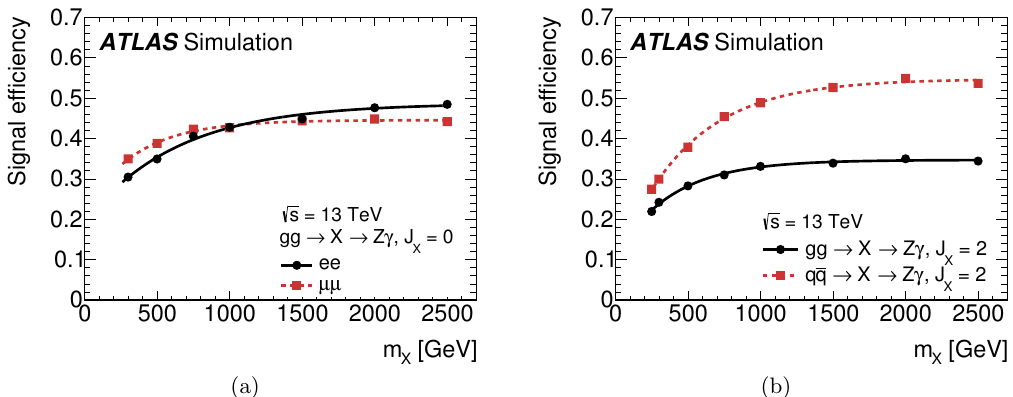
Figure 4 . Reconstruction and selection e(cid:14)ciency (including kinematic acceptance) for the X ! Z(cid:13) (cid:12)nal state as a function of the resonance mass m X (a) for a spin-0 resonance via gluon-gluon fusion, separately for the ee and the (cid:22)(cid:22) categories, and (b) for a spin-2 resonance produced via either the gluon-gluon or the quark-antiquark initial states. The markers show the e(cid:14)ciencies obtained from simulation, while the curves represent the parameterisation used in the analysis. The e(cid:14)ciencies are given with respect to (a) X ! Z ( ! ee ) (cid:13) and X ! Z ( ! (cid:22)(cid:22) ) (cid:13) , respectively, and (b) X ! Z ( ! ‘‘ )